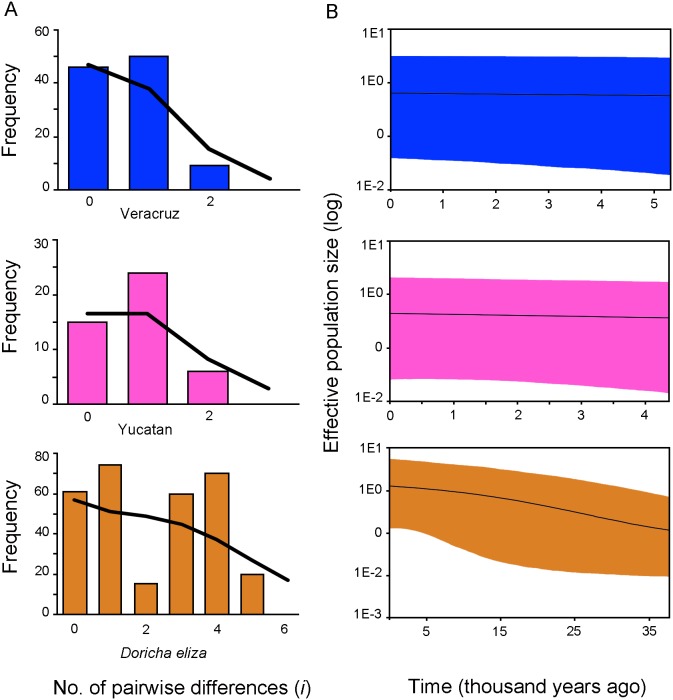
Mistmatch distributions (A) and Bayesian skyline plots (B) showing historical demographic trends of Veracruz, the Yucatan and Doricha eliza populations using mitochondrial sequences.Histograms correspond to observed frequencies of pairwise nucleotide differences, and lines represent the expected frequencies under a sudden expansion model. The y axis of the skyline plots is the product between effective population size and the generation time and the y axis is time in thousands of years. A mutation rate of 2.9×10–2 substitutions/site/lineage/million years (s/s/l/My) for ND2, 2.2×10–2 s/s/l/My for ATPase, and 1×10–3 s/s/l/My for 20454 based on rates obtained for Hawaiian honeycreepers [33]. Solid lines represent median estimates and shaded areas represent 95% confidence intervals. The color-coding, as in Fig. 2, is blue for Veracruz, rose-pink color for the Yucatan, and orange for all populations of D. eliza.